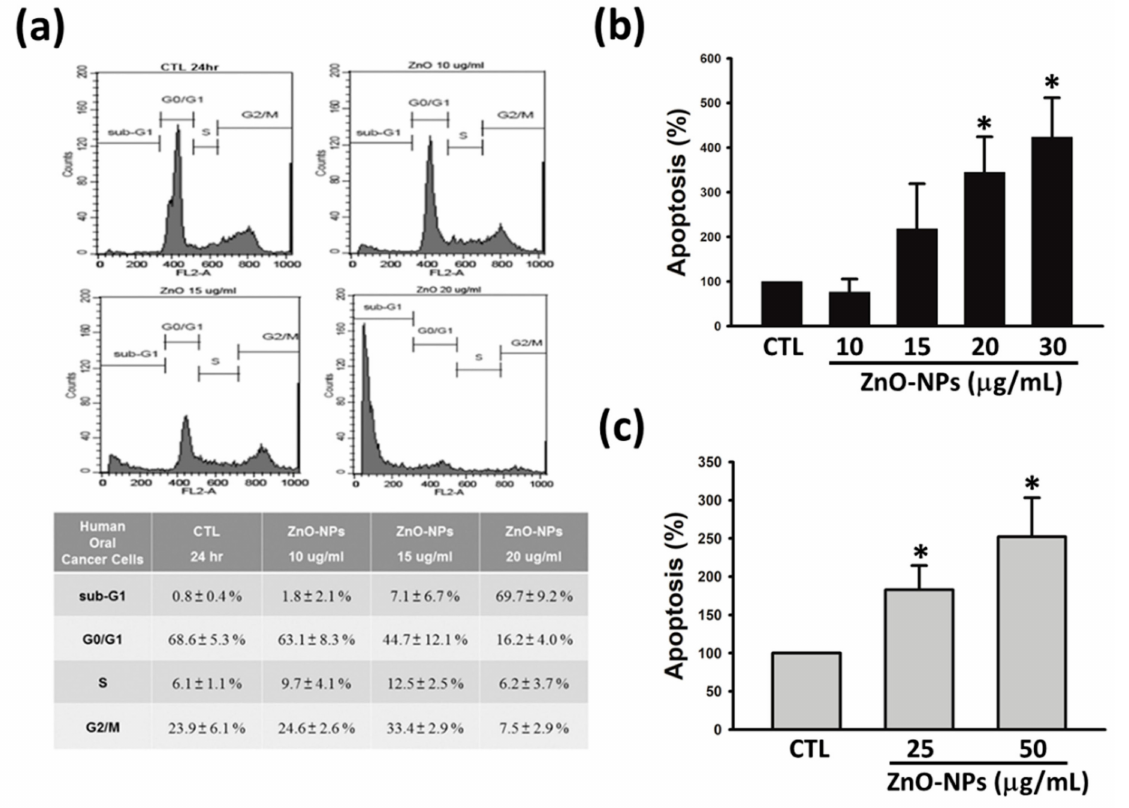
Figure 2. E ff ects of ZnO-NPs on cell cycle progression and apoptosis in human GSCC cells. ( a ) Ca9-22 cells were treated with ZnO-NPs (10–20 µ g / mL) for 24 h, and subsequently analyzed by propidium iodide (PI) staining to determine the cell cycle distribution. Lower panel, quantitative data were based on histograms. Ca9-22 ( b ) and OECM-1 ( c ) cells were treated with the indicated concentrations of ZnO-NPs for 24 h to determine apoptosis using a Cell Death ELISA PLUS kit. Data are expressed as the mean ± SEM of at least three independent experiments. * p < 0.05 compared to the control